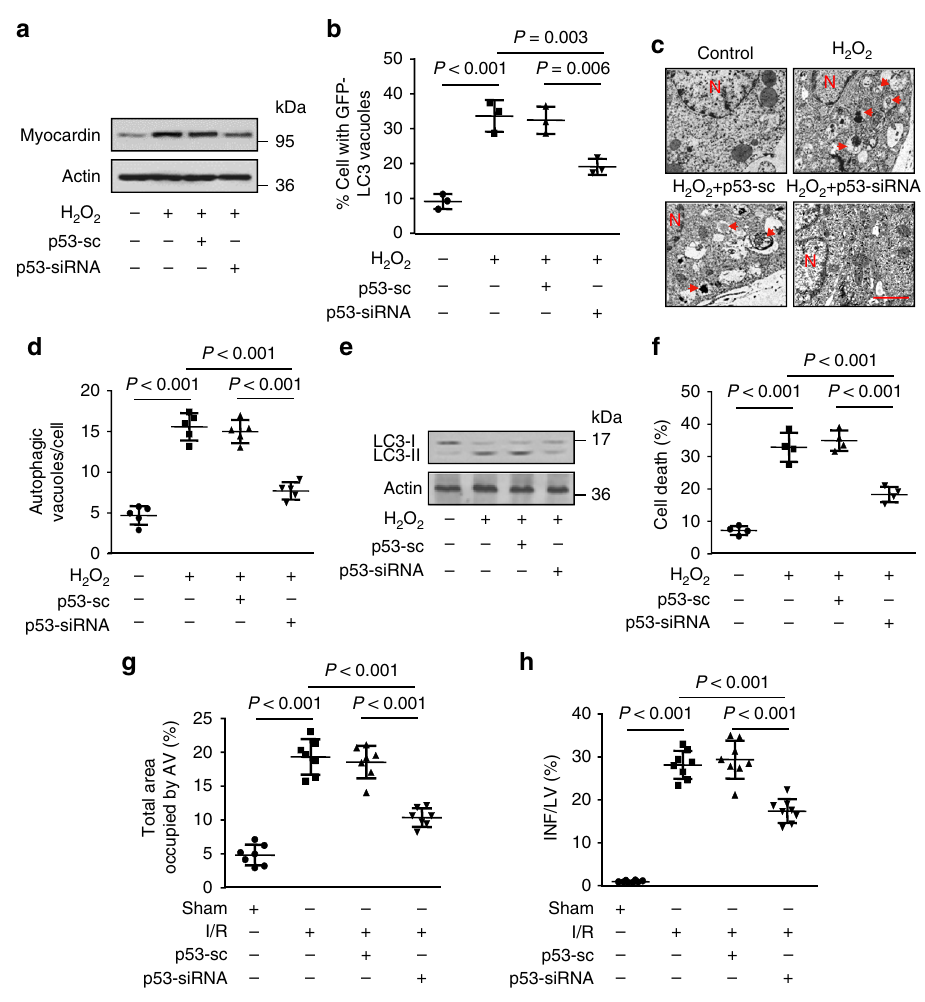
Fig. 3 Knockdown of p53 inhibits autophagy in vitro and in vivo. a Knockdown of p53 suppresses H 2 O 2 -induced myocardin expression. Cardiomyocytes were infected with adenoviral p53-siRNA or p53-sc. Twenty-four hours after infection, cells were treated with H 2 O 2 . Myocardin levels were analyzed by immunoblot. b Knockdown of p53 inhibits punctate accumulations of GFP-LC3. Cardiomyocytes were infected with adenoviral GFP-LC3, p53-siRNA and or p53-sc. Twenty-four hours after infection cells were treated with H 2 O 2 . The percentage of cells with GFP-LC3 puncta was quanti fi ed. n = 3. c , d p53 knockdown reduces autophagic vacuoles. Cardiomyocytes were treated as described in ( a ). Representative EM images were shown ( c ). Bar = 2 µ M. The arrows depict autophagosomes, and the nucleus is denoted by N. Quanti fi cation of autophagic vacuoles was shown in ( d ). n = 5. e Representative immunoblot for conversion of LC3-I to LC3-II. Cardiomyocytes were treated as described in ( a ). The positions of LC3-I and LC3-II are indicated. f p53 knockdown reduces H 2 O 2 -induced cell death. Cardiomyocytes were treated as described in ( a ). Quantitation of cell death is shown. n = 4. g Knockdown of p53 reduces autophagy in vivo. Mice were injected with adenoviral p53-siRNA or p53-sc as described in methods, and then were subjected to 45 min ischemia and 3 h reperfusion (I/R). Quanti fi cation of autophagic vacuoles in the area-at risk was shown. n = 7. h p53 knockdown reduces I/R-induced myocardial infarction. Mice were treated as described in ( g ). The infarct sizes were quanti fi ed. LV left ventricle, INF infarct area. n =